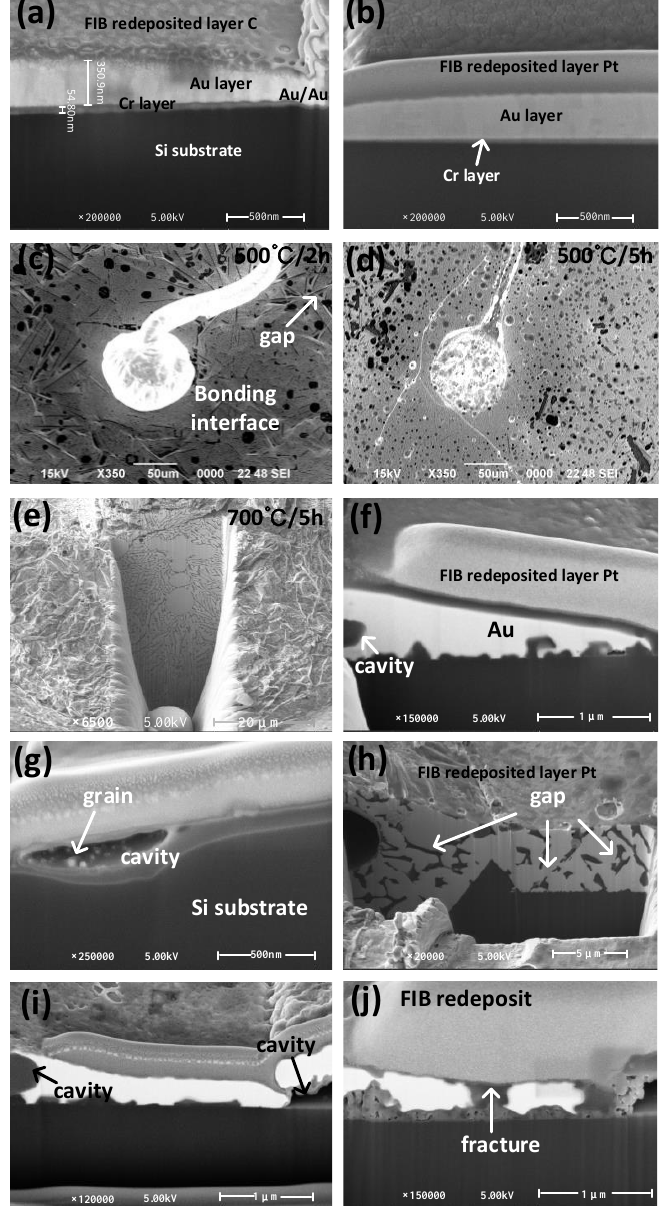
Figure 5. SEM image of FIB cross section cutting of samples covered with a C/Pt (1 µm) electrodeposition layer on gold electrode surface before and after high-temperature annealing as well as the overall SEM image of the uncut bond site after annealing and the SEM image of the FIB cross section cutting of the sample without covered with a C/Pt electrodeposited layer. Overview image of electrode covered with ( a ) C electrodeposition layer and ( b ) Pt electrodeposition layer. Bonding interface image after annealing at ( c ) 500 ◦ C for 2 h and ( d ) 500 ◦ C for 5 h. ( e ) SEM image of bonding interface sectional drawing cut by FIB after annealing at 700 ◦ C for 5 h. SEM image of FIB cut with 300 nm thick electrode annealed at ( f ) 500 ◦ C for 2 h and ( g ) 500 ◦ C for 5 h, SEM image of FIB cut with 400 nm thick electrode annealed at ( h ) 500 ◦ C for 5 h and ( i ) 700 ◦ C for 2 h. ( j ) SEM image of FIB cut with 300 nm thick electrode annealed at 700 ◦ C for 5